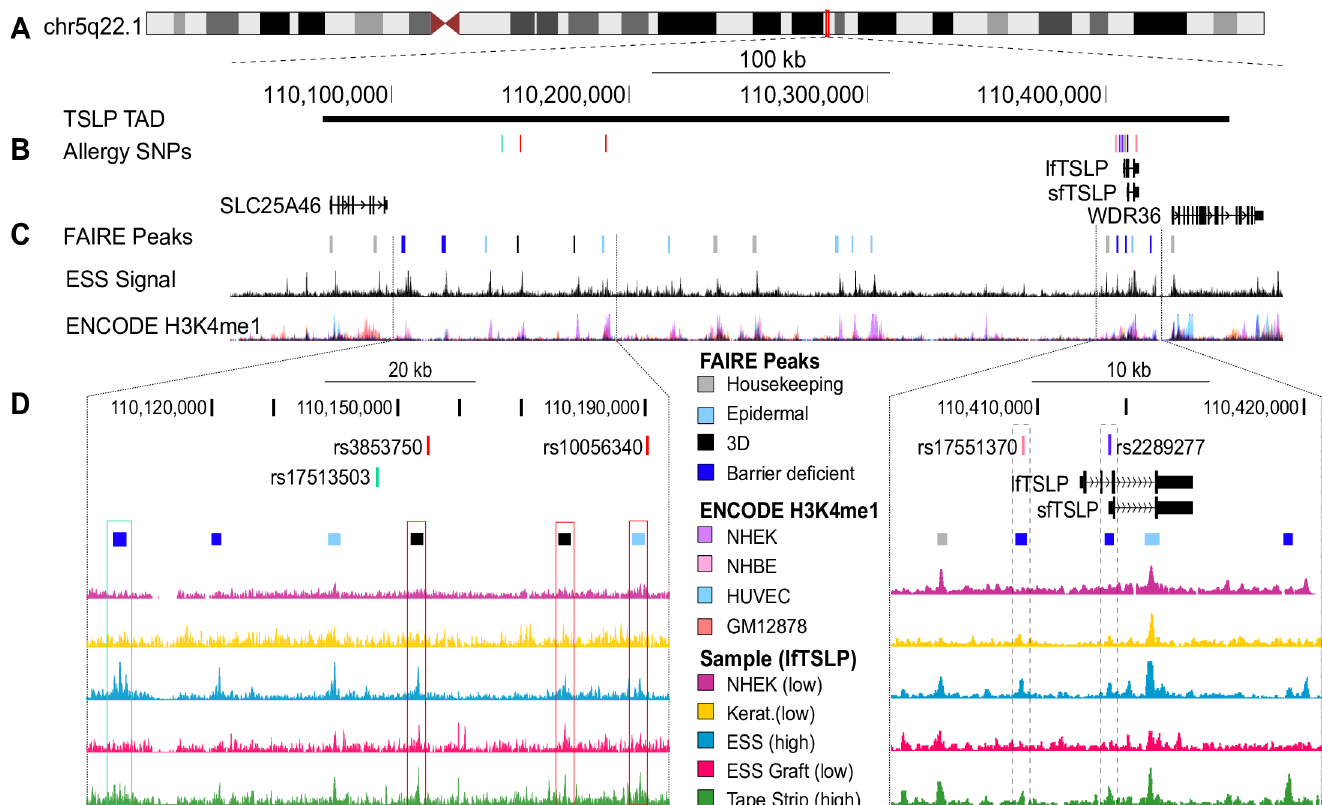
Fig 5. Dynamic FAIRE peaks in the TSLP transcriptionally associated domain (TAD) associate with allergic disease-associated SNPs. (A) The most likely TSLP regulatoryregionwas identifiedusing publishedHi-C data from several cell types to infer the TAD around TSLP [39]. (B) GWAS SNPs locatedwithin the TSLP TAD (n = 16); all are associatedwith allergicdisease(see Table 1 and Methods). (C) FAIRE peaks within the TSLP TAD designated by category: Housekeepingpeaks which were present in our samples as well as in at least 3 ENCODE FAIRE cell types (grey); epidermal peaks, present in our samples but not in non-epidermal ENCODE cell types (light blue); Three-dimensional (3D) peaks present only in stratified epidermis (black); and Barrier-deficient peaks that were present in the context of insufficientepidermal barrier (ESS and Tape-strip) but absent in an intact barrier (Graft) or culture monolayer(keratinocytes, NHEK; dark blue). Representative ESS signalis shown below, along with ENCODE H3K4me1.Color designations for the most prominent cell types in the H3K4me1 track are indicatedin the legend.(D) FAIRE signalsfrom ENCODE NHEK, cultured Keratinocytes, ESS, Grafted ESS, and Tape-strippedESS are shown for the TSLP locus (right panel)as well as a distal region~200-250kb upstream of TSLP (left panel)containing allergy-associated SNPs and dynamic peaks. Two Barrier-deficient peaks (dashedboxedregions, right panel)overlap rs17551370 and rs2278277,respectively.Rs17551370is associatedwith allergicrhinitis [42] and rs2289277 is a known expressionquantitative trait locus (eQTL) [43] for TSLP and associated with changesin IgE levels [44, 45]. Four distal (left panel)Epidermal,3D, and Barrier-deficient FAIRE peaks are in high (R 2 = 0.8–1) linkagedisequilibrium (LD) with allergy-associatedSNPs. Peaks are boxedin the same color as the SNP they are in LD with. Full LD plots and analysisare in S4 Fig and Table